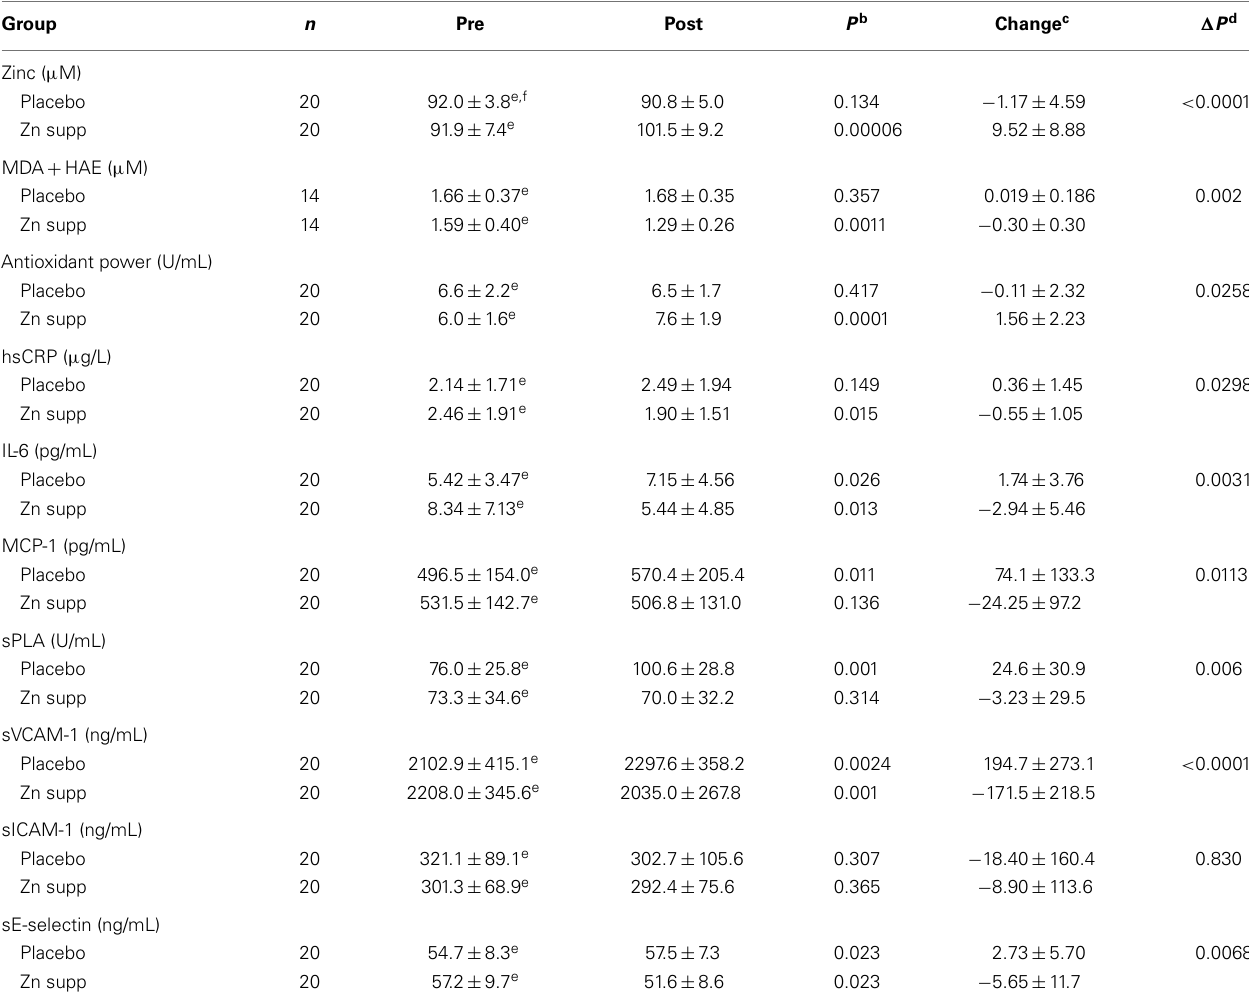
Table 5 | Changes in plasma zinc, oxidative stress makers, and inflammatory cytokines/molecules in zinc supplemented (Zn supp) elderly subjects a (6)